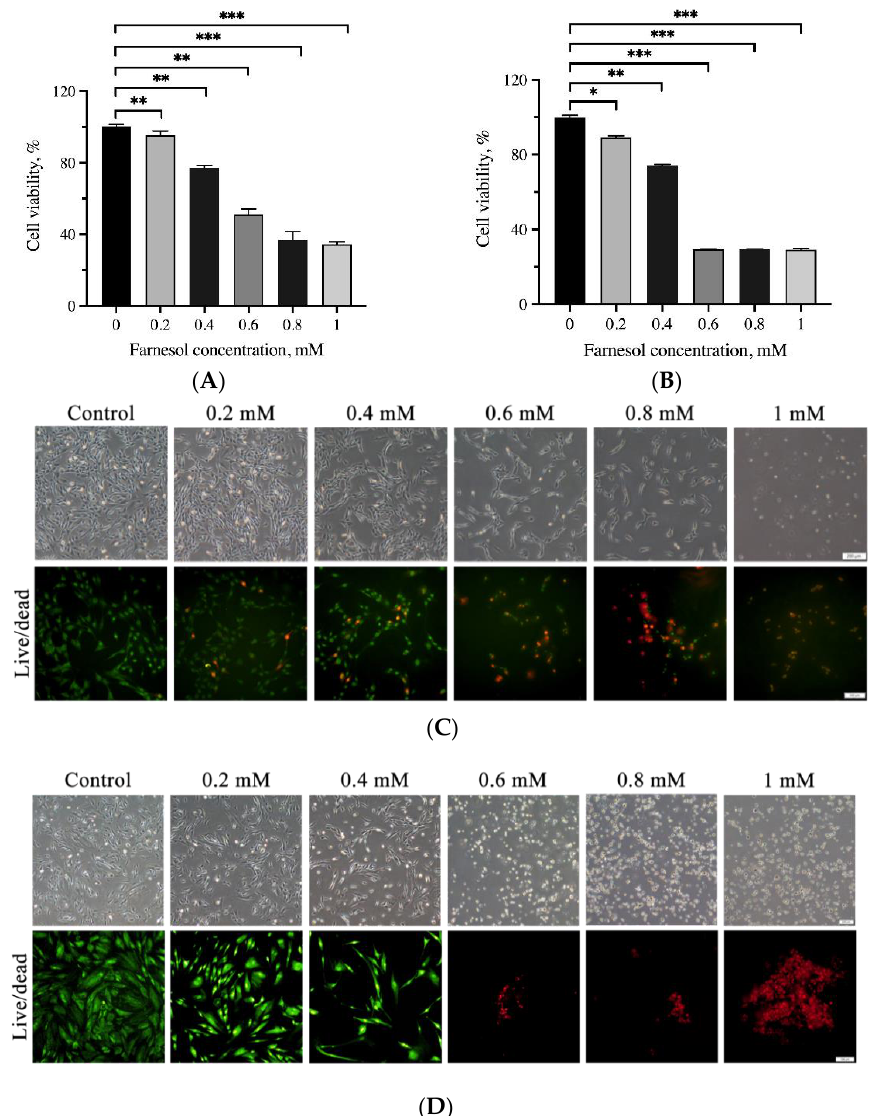
Figure 4. Cell viability determined using the MTT assay for ( A ) C2C12 myoblasts and ( B ) tenocytes after treatment with 0.2–1.0 mM farnesol over 24 h. Live/dead cell staining for ( C ) C2C12 myoblasts and ( D ) tenocytes. Green and red indicate live and dead cells, respectively. Significant differences are based on comparisons with the control group (without addition of farnesol), * p < 0.05, ** p < 0.01, and *** p < 0.001. Scale bar: 50 µ